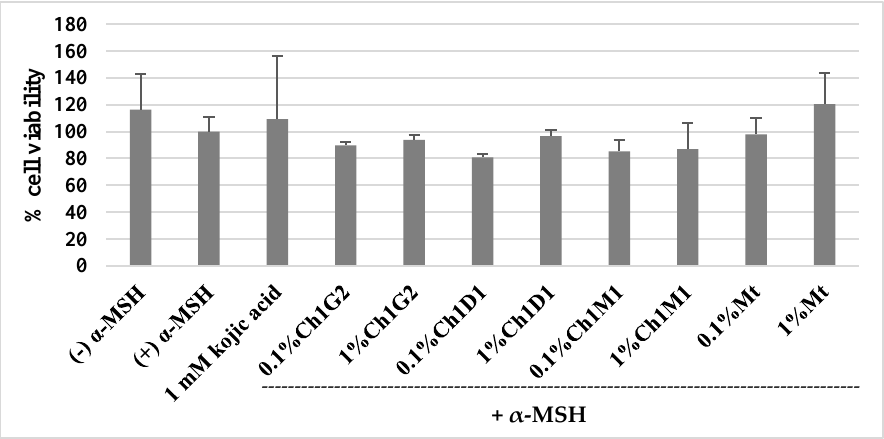
Figure 1. Percentage of cell viability of B16-F10 melanoma after treatment with kojic acid (positive control), NADES and methanol (MT) extracts of M. alba in the presence (+) or absence (−) of α-MSH (10 nM) (mean ± SD, n = 3).